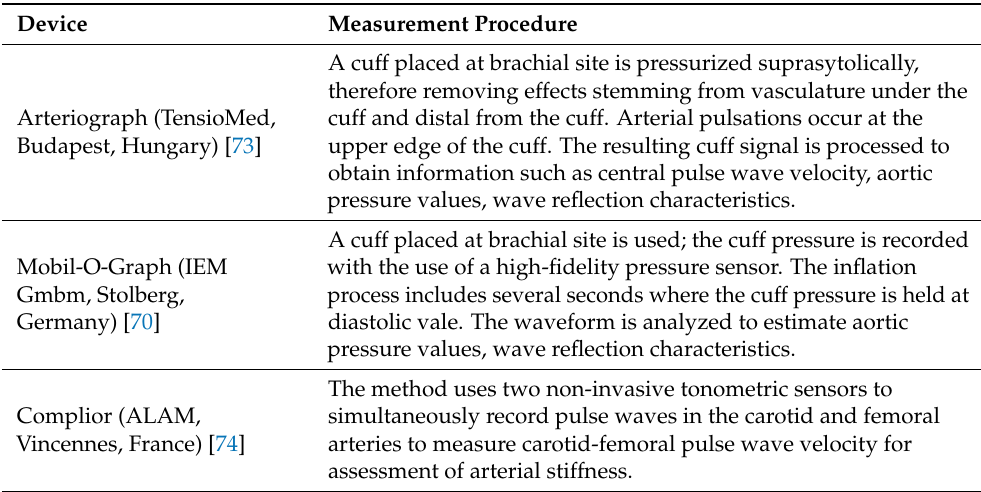
Table 1. Examples of technologies involving variations of cuff, ECG, PPG, tonometric